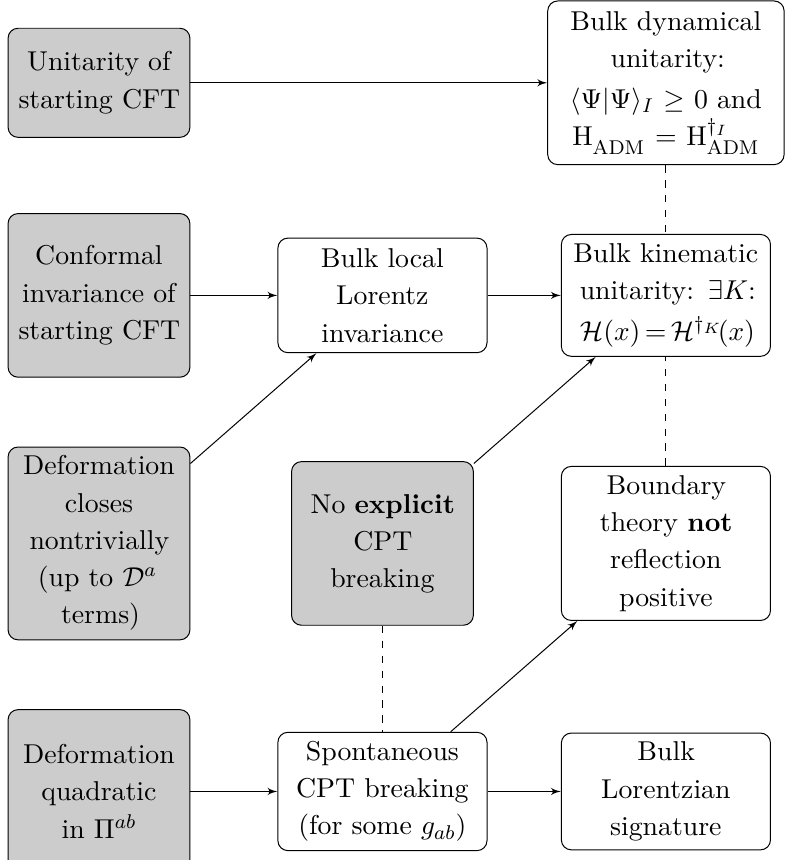
Figure 12 . Chart showing how various properties of the T 2 deformed theory relate to properties of the gravity theory. The shaded boxes highlight properties that we impose on the field theory as assumptions. The unshaded boxes correspond to emergent properties of either the field theory or the gravity theory, which arise as consequences. The arrows show implications. The dashed lines illustrate the contrast between two subtly distinct